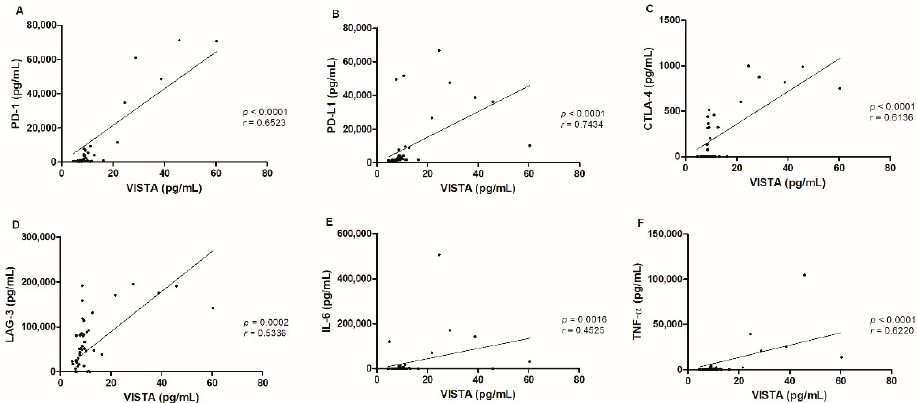
Figure 3. Serum VISTA levels in cats with mammary carcinoma were correlated with several immune checkpoint proteins, namely ( A ) PD-1 (*** p < 0.0001), ( B ) PD-L1 (*** p < 0.0001), ( C ) CTLA-4 (*** p < 0.0001), ( D ) LAG-3 (*** p = 0.0002), ( E ) IL-6 (** p = 0.0016) and ( F ) TNF- α (*** p < 0.0001) serum levels.